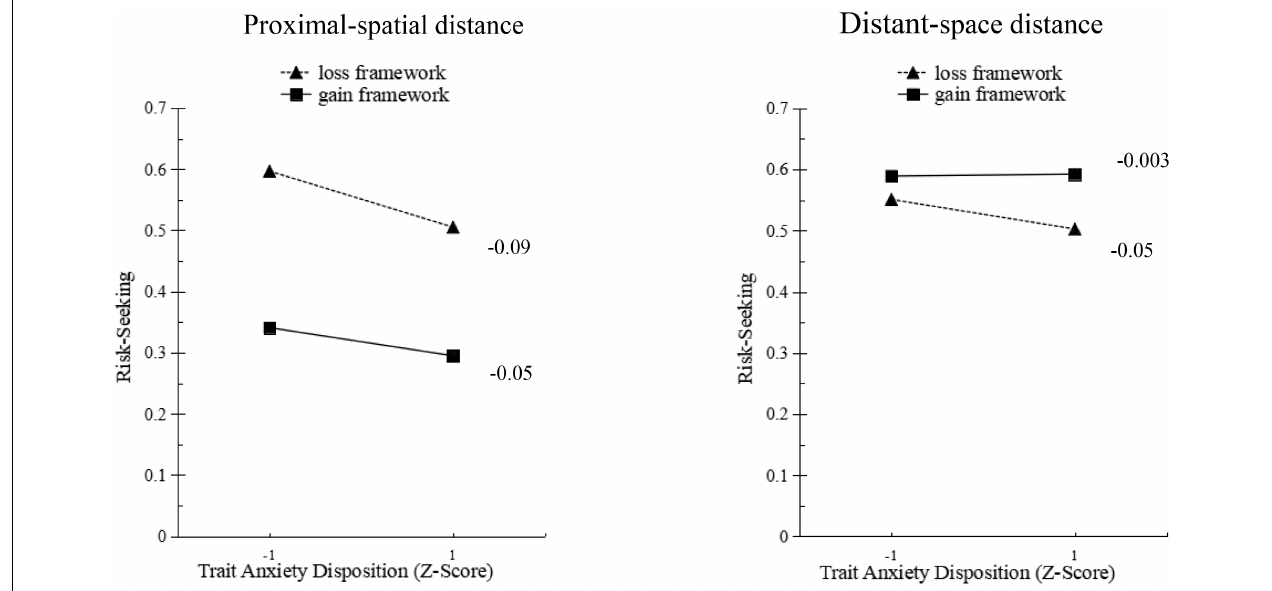
FIGURE 2 | The impact of framing effect and trait anxiety on risk preference under different spatial distance